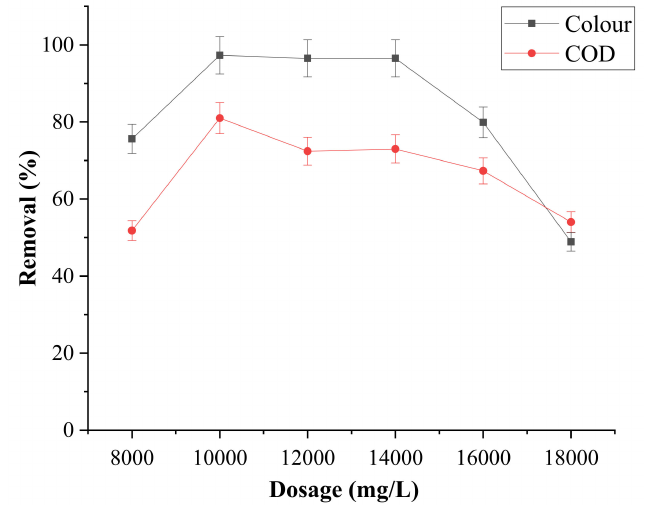
Figure 3. Influence of SnCl 4 dosage (6000–18,000 mg/L) on the removal of colour and COD at optimum pH